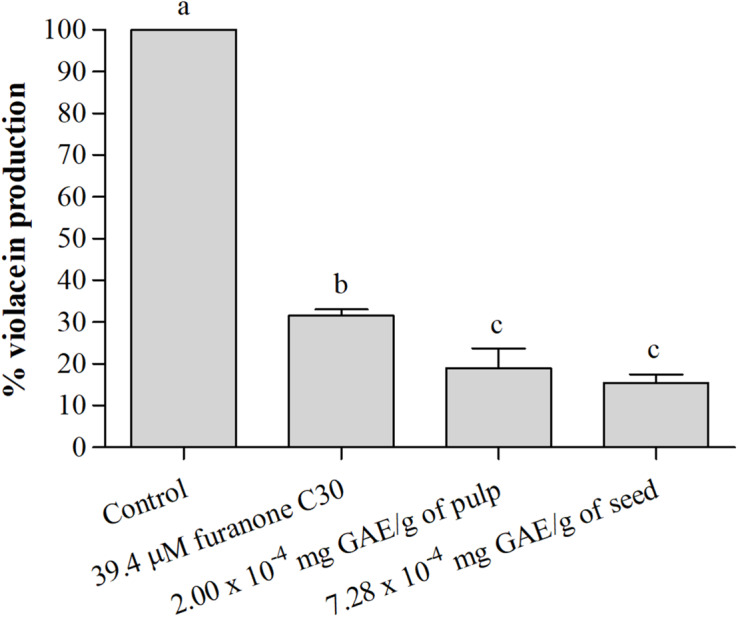
Percentage (%) of violacein production by C. violaceum ATCC 12472 in the absence and presence of the active films incorporating pulp and seed phenolic extracts of S. cumini (L.) Skeels. Means followed by different letters differ statistically (p < 0.05).